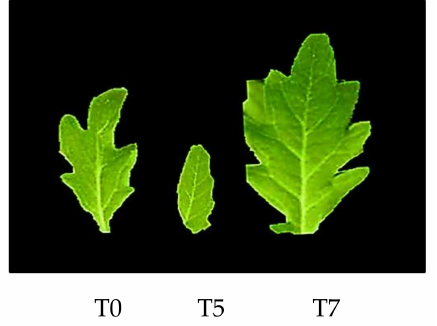
Figure 3. Effect of SWE on mitigating salt stress effects on leaf surface area expansion.